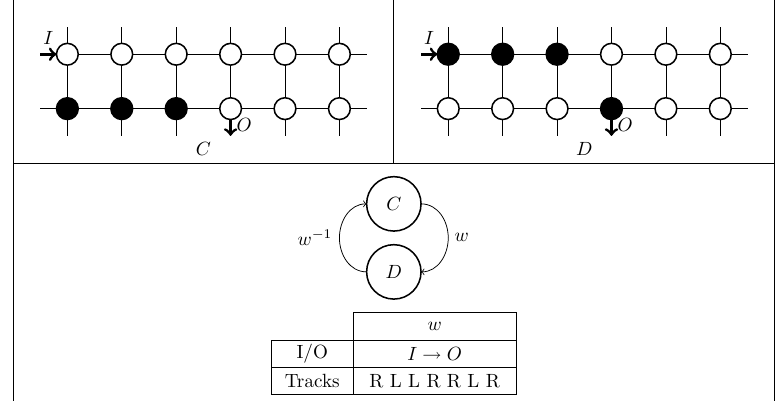
Figure 16. Cross diagram.